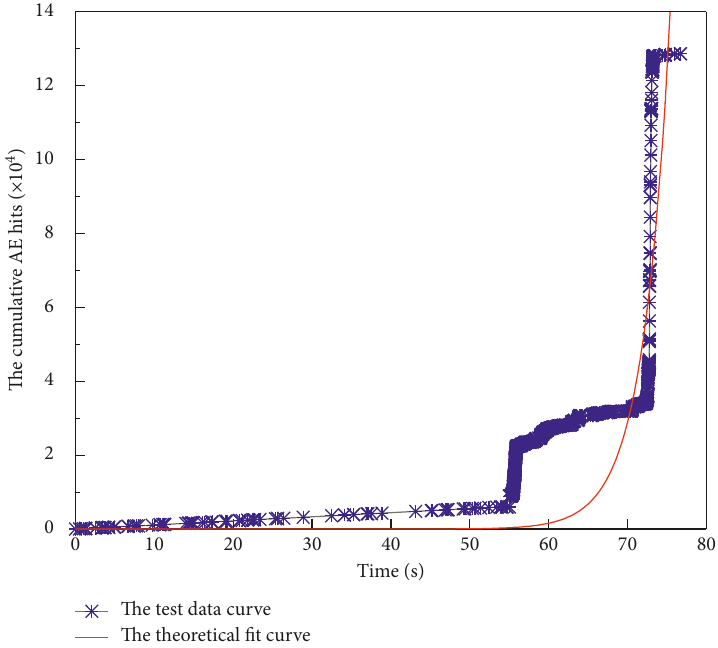
Figure 6: Relationship between the cumulative AE hits and time.